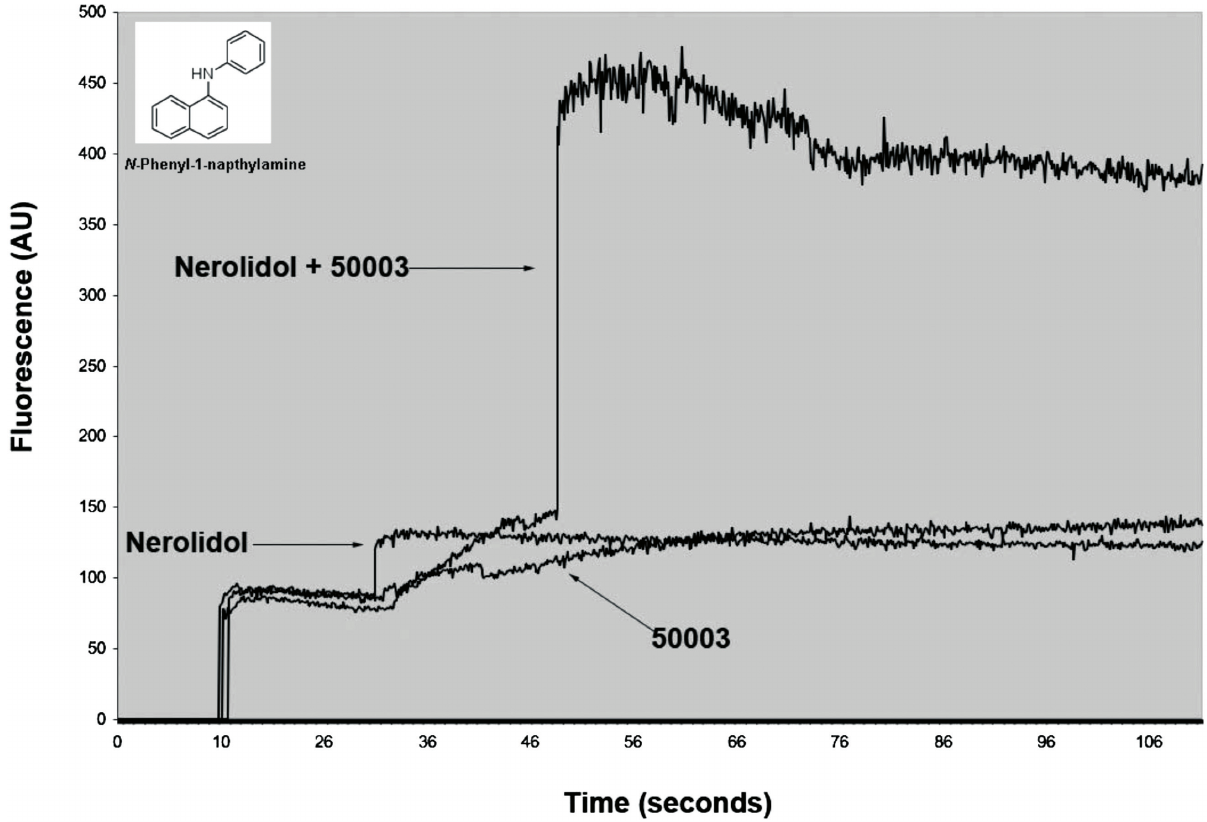
Figure 3. NPN uptake assay with PMX 50003 and nerolidol using E. coli ATCC 25922. Time course of increase in NPN uptake with 50003 (31.25 µg/mL), nerolidol (200 µM) or the combination. NPN at 10 µM was added at 10 sec and allowed to stabilize before addition of either nerolidol or 50003 at 30 sec. When used in combination, the second component was added at 50 sec. Enhanced uptake of NPN was measured by an increase in fl uorescence, the result of partitioning of NPN into the outer membrane.